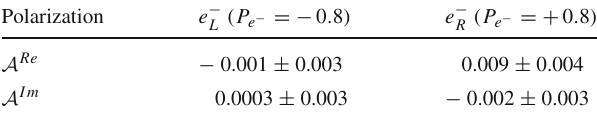
Table 6 Reconstructed values of the CP-odd asymmetries from a Monte Carlo simulation of the CLIC_ILD detector response to t ¯ t events √ s = 380 GeV. The quoted produced in electron–positron collisions at uncertainties are due to the limited statisitcs of the simulated samples Polarization e − ( P e − = − 0 . L